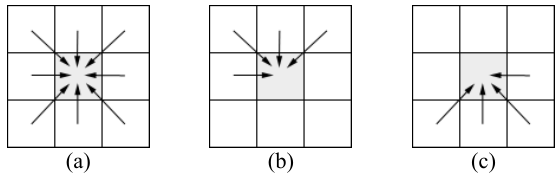
Figure 3. Concept of splitting 8 scanlines spanning the 2D image space (a) into 2 passes (b) down-right and (c)